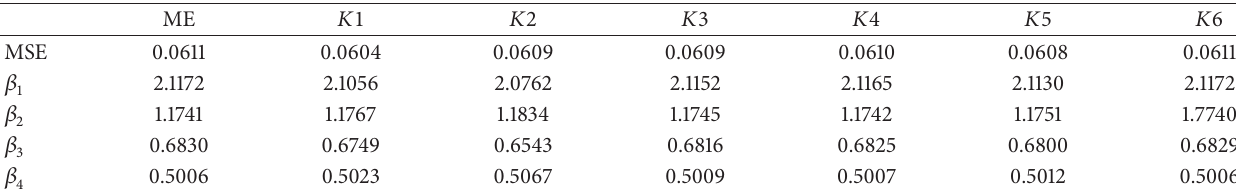
Table 21: Comparative performance of the